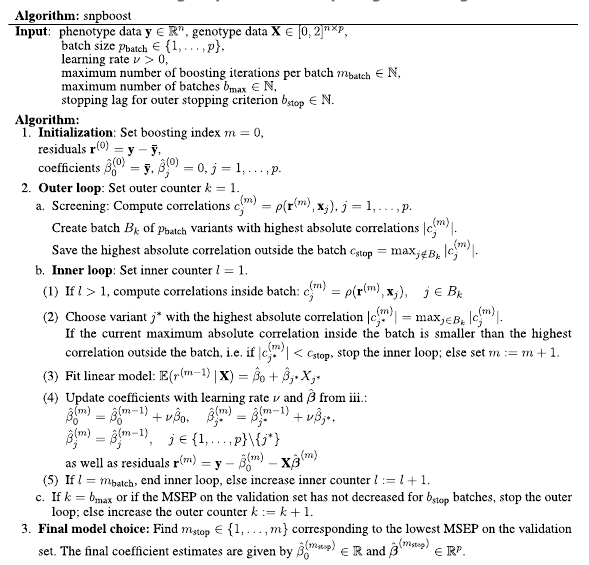
TABLE 1 De fi nition of the snpboost algorithm without additional covariates. If additional covariates apart from the genetic variants should be included in the model, they are treated as mandatory covariates — similar to the intercept. The additional covariates are included in each single base-learner and are hence updated in each boosting step without competing with the genetic